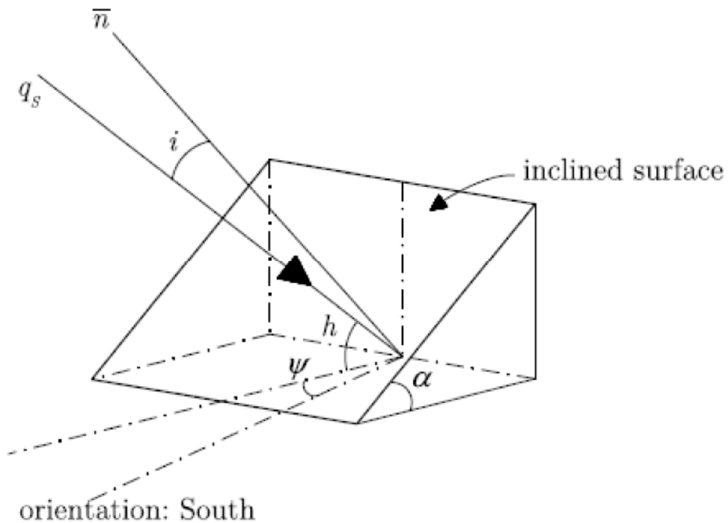
Figure 1. Arbitrarily inclined surface and incident sun beam (adapted from [34]).